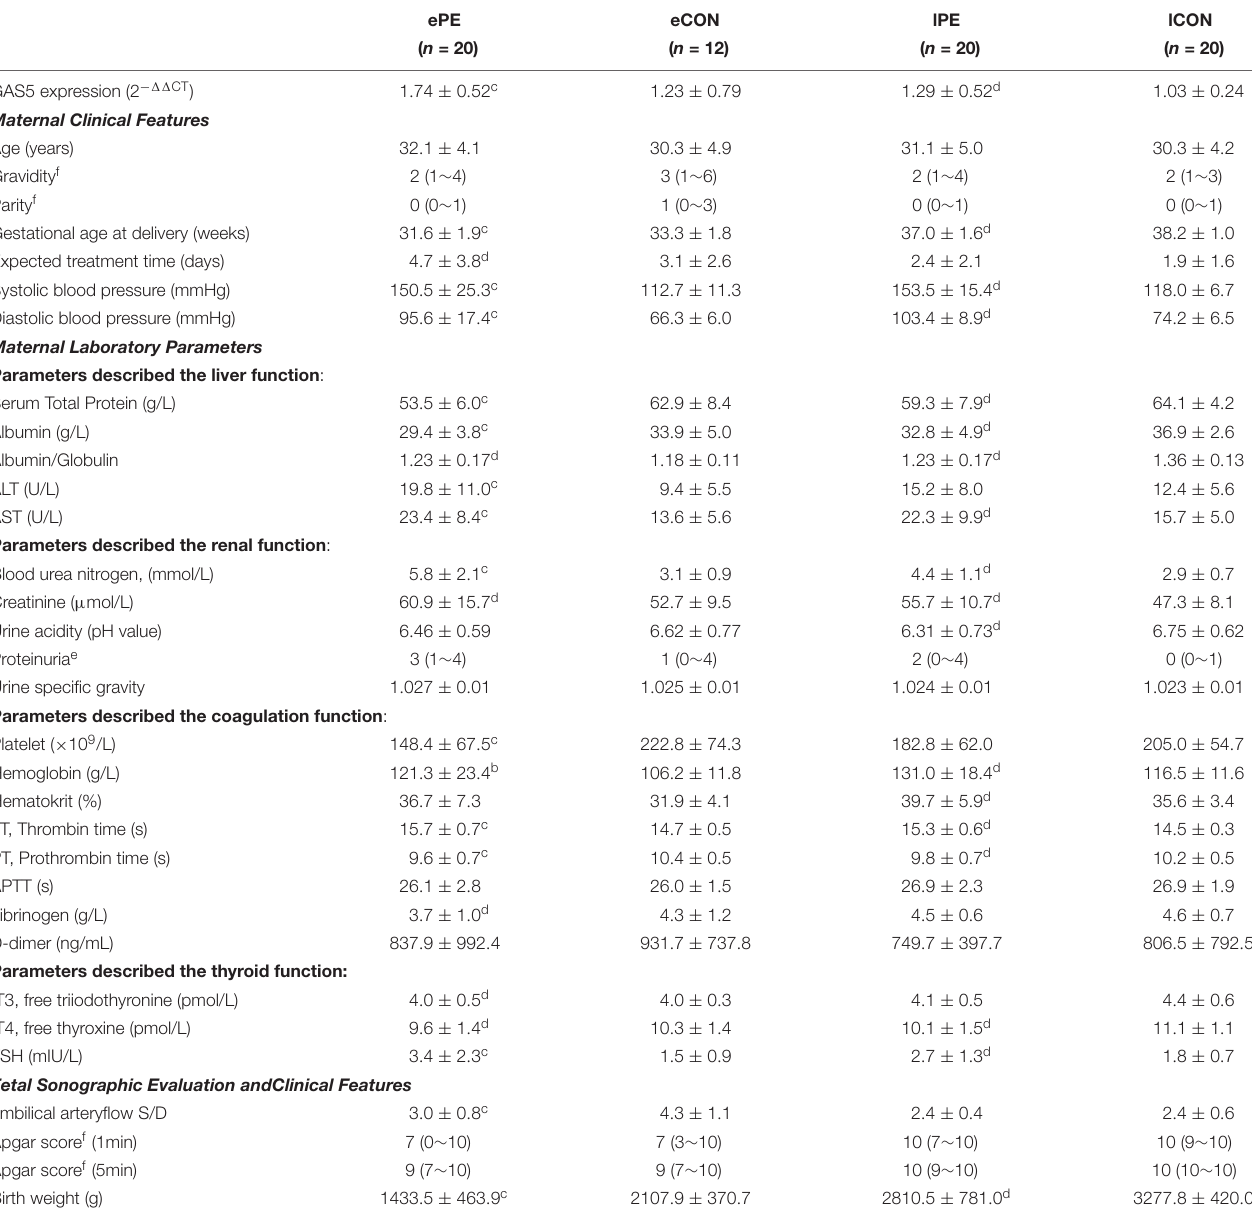
TABLE 1 | Expression level of lncRNA GAS5, Clinical features and Laboratory parameters of the subjects. a